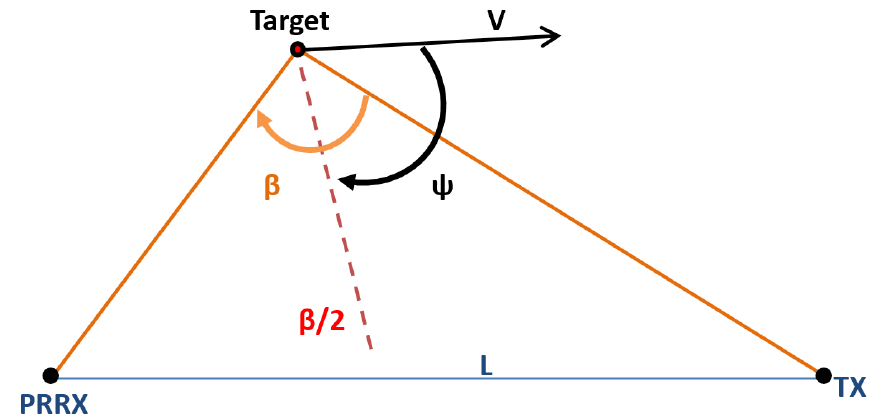
Figure 4. Geometry for bistatic range resolution calculation.